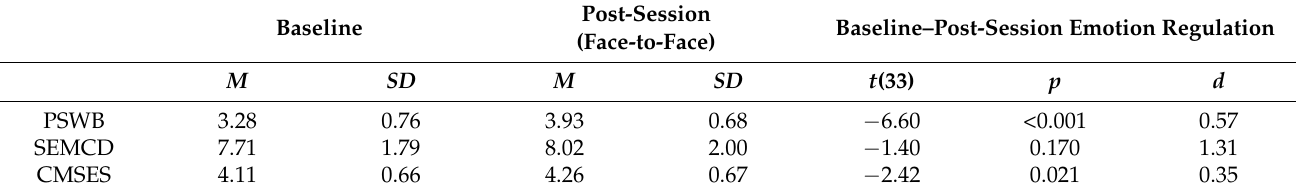
Table 3. Baseline and post-session scores of PSWB, SEMCD, and CMSES in the experimental group.